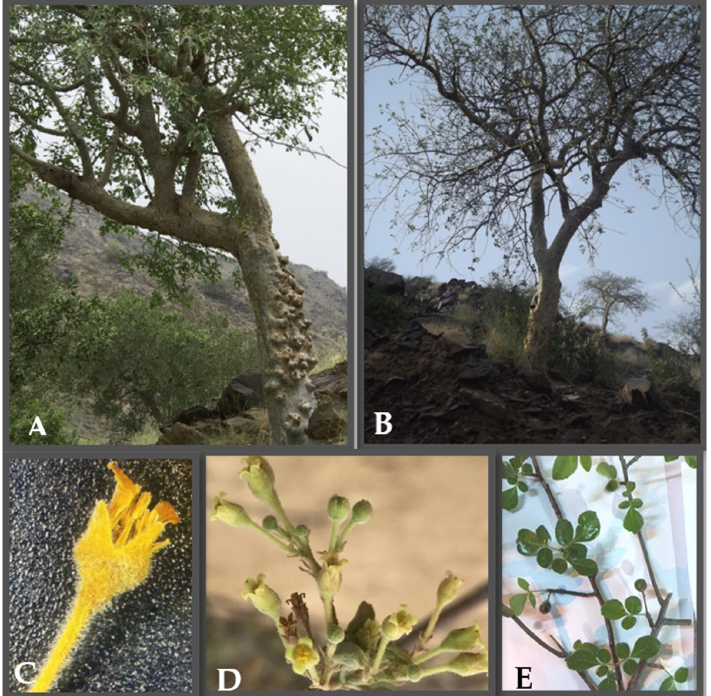
Figure 6. Commiphora kataf ; ( A ): whole plant in leafy stage; ( B ): whole plant in naked stage; ( C ): A magnified flower at 2 × , ( D ): flowers at normal view; ( E ): fruits and